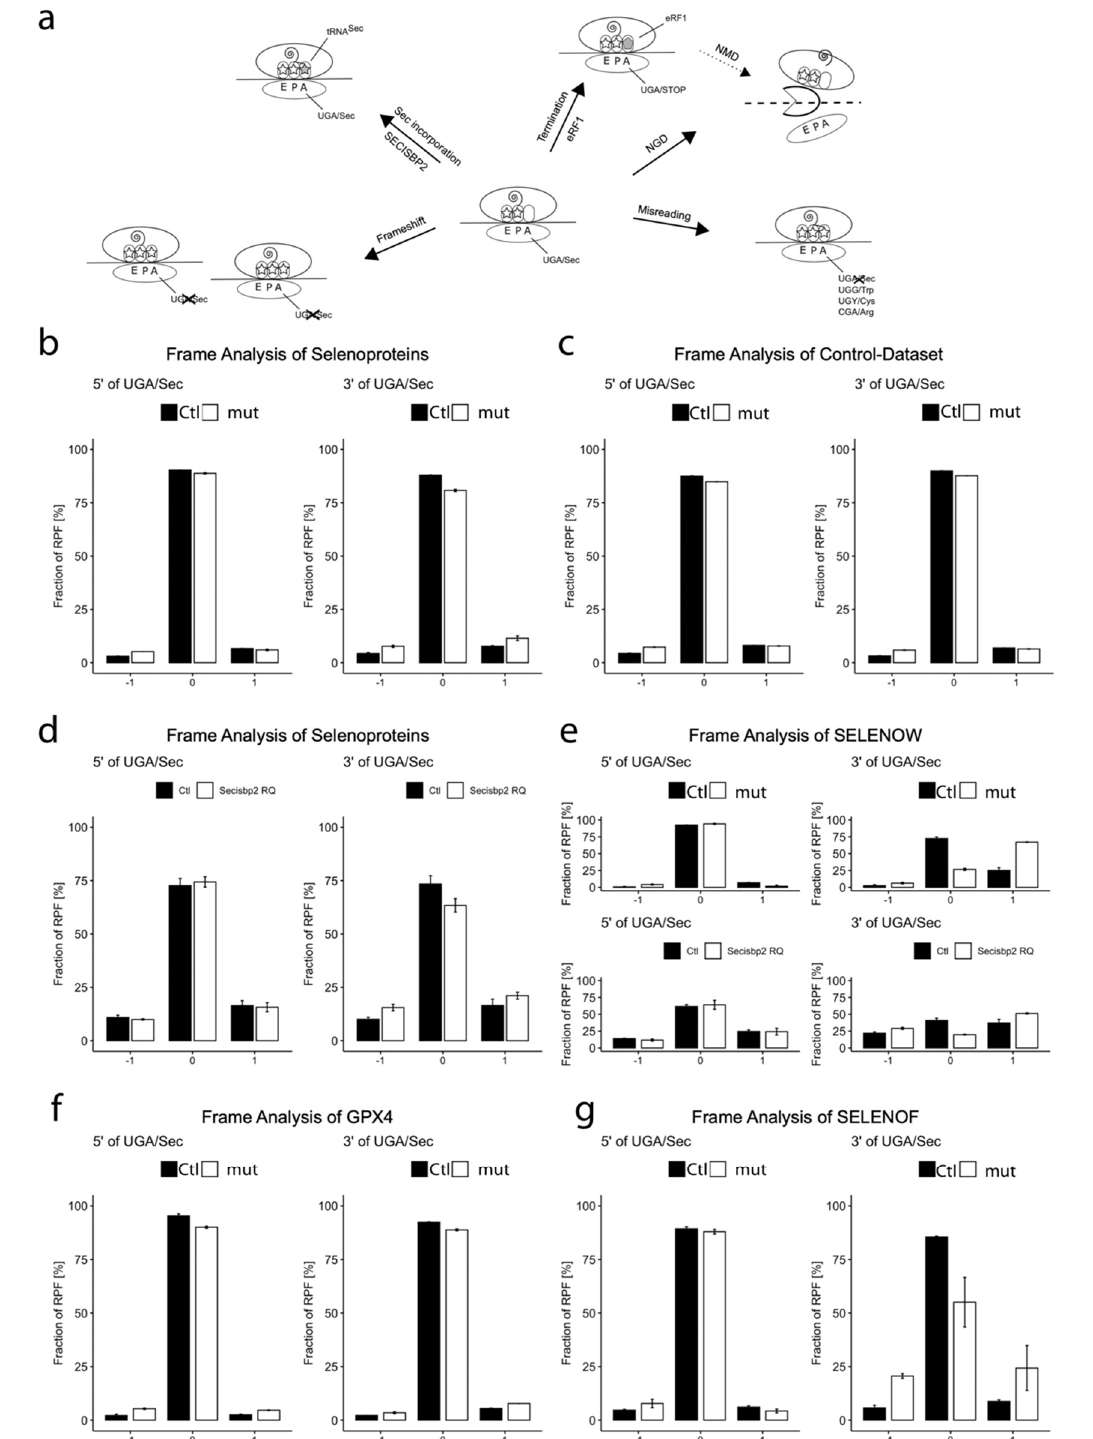
Figure 6. Reading frame analysis of selenoproteins. ( a ) Possible outcomes when a translating ribosome encounters a UGA/Sec codon. If Sec-tRNA Sec is not readily available, termination, mRNA degradation, misreading or frameshifting may occur. The choice is influenced by trans-acting factors such as SECISBP2 , possibly others, and by the context of primary or secondary (i.e., selenocysteine redefinition elements) RNA structure. In addition, incomplete modification of tRNA Sec may also disfavor efficient Sec incorporation depending on mRNA context. (b) The fraction of RFPs (%) in frame –1, 0 and +1 5 ′ (left) and 3 ′ (right) of the UGA/Sec codon is represented for control and SECISBP2 -mutant HAP1 cells. ( c ) The fraction of RFPs (%) in frames –1, 0 and +1 5 ′ (left) and 3 ′ (right) for a control dataset, consisting of the whole transcriptome except for the selenoproteins. A